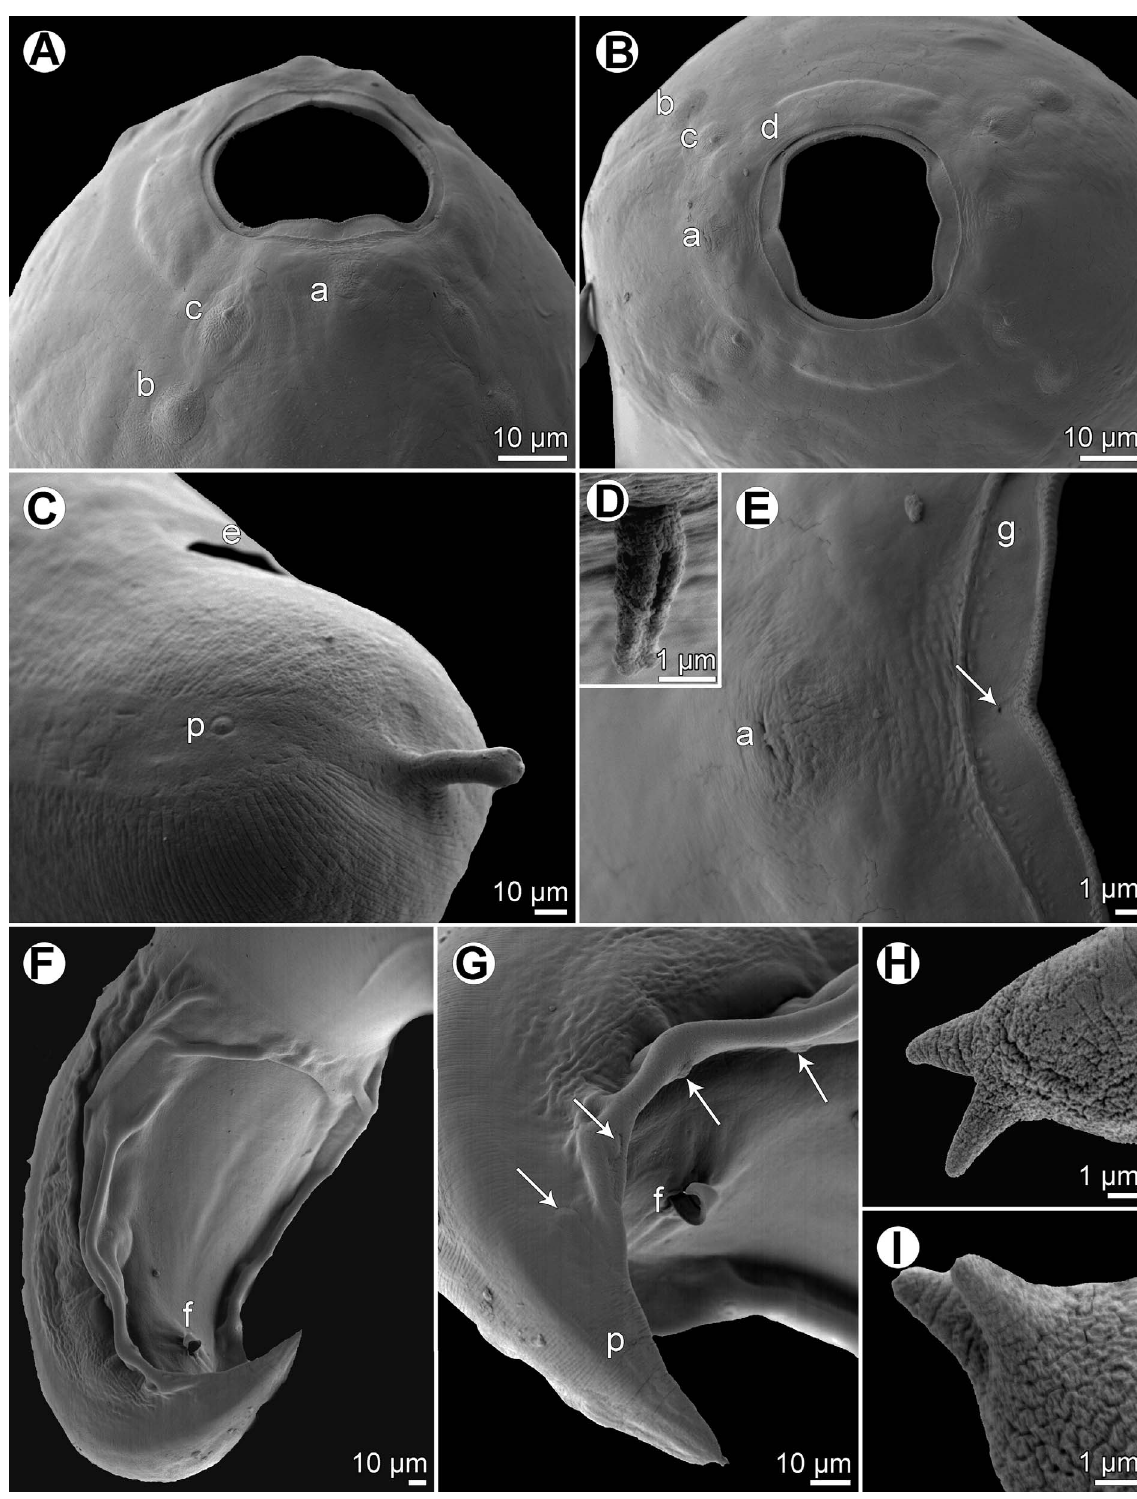
Figure 4. Procamallanus ( Spirocamallanus ) bothi n. sp., scanning electron micrographs. (A, B) Cephalic end, lateral and apical views, respectively; (C) female tail, sublateral view; (D) deirid; (E) region of amphid, apical view (arrow indicates lateral pore on margin of oral aperture); (F) posterior end of male, subventral view; (G) tail of male, ventrolateral view (arrows indicate pedunculated caudal papillae); (H) tail tip of male (lateral view); (I) tail tip of female, sublateral view). (a) amphid; (b) cephalic papilla of external circle; (c) cephalic papilla of middle circle; (d) cephalic papilla of internal circle; (e) anus; (f) cloacal aperture; (g) margin of oral aperture; (p)